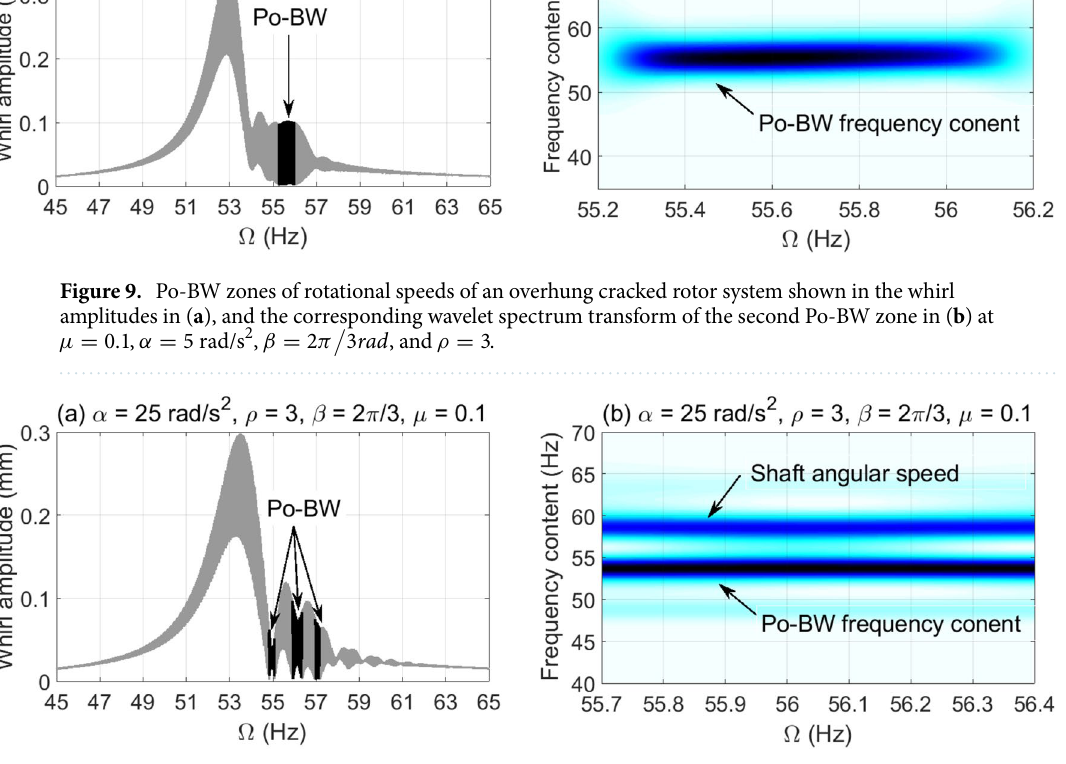
Figure 10. Po-BW zones of rotational speeds of an overhung cracked rotor system shown in the whirl amplitudes in ( a ), and the corresponding wavelet spectrum transform of the second Po-BW zone in ( b ) at 3 rad , and ρ = 3 µ = 0.1 , α = 25 rad/s 2 , β = 2 π (cid:31)